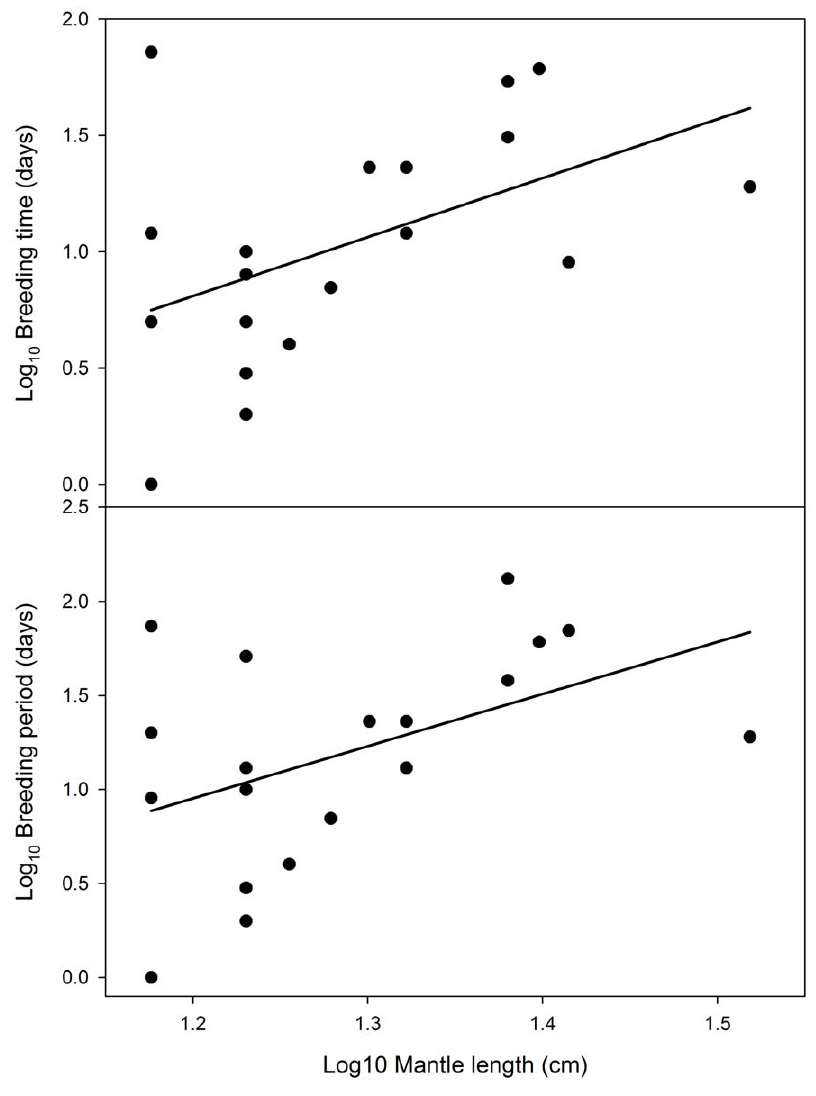
Figure 5. Relationships between S.apama size and breeding durations using data in Payne et al. [ 27 ] . Breeding time is the number of days each individual was present at the Point Lowly breeding aggregation, and breeding period is the number of days between the first and last day that each individual was present. Least-squares regression identified a significant effect of size for both metrics ( n = 19; P , 0.05, r 2 = 0.24 and 0.22 for breeding time and duration,